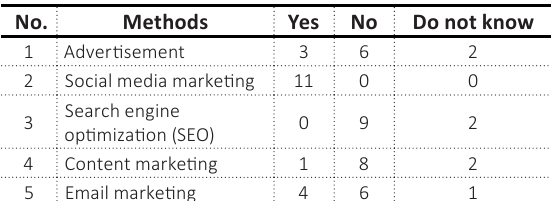
Table 2. Methods of digital marketing strategy in handicraft businesses